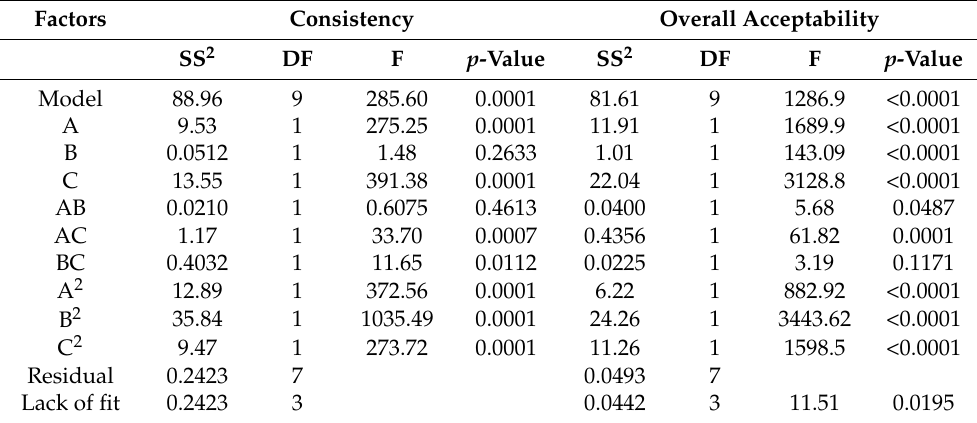
Table 3. Results of regression analysis of avocado fruit pulp incorporated juice (consistency and overall